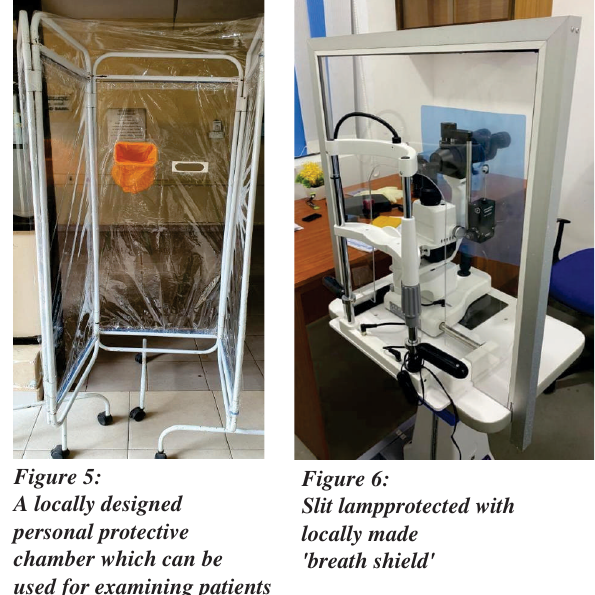
Figure 6: Slit lampprotected with locally made 'breath shield'